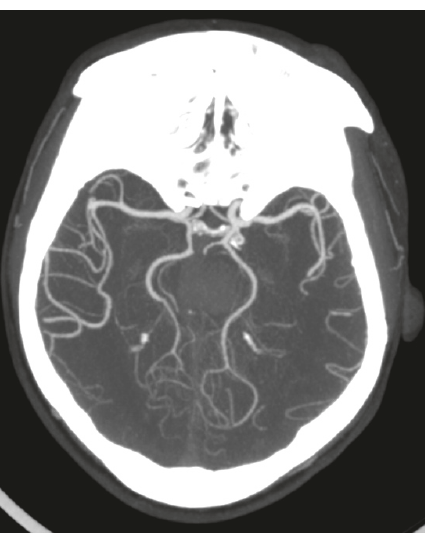
Figure 4: Axial cerebral CTA image showing bilateral fetal PCA with right P1 segment aplasia.